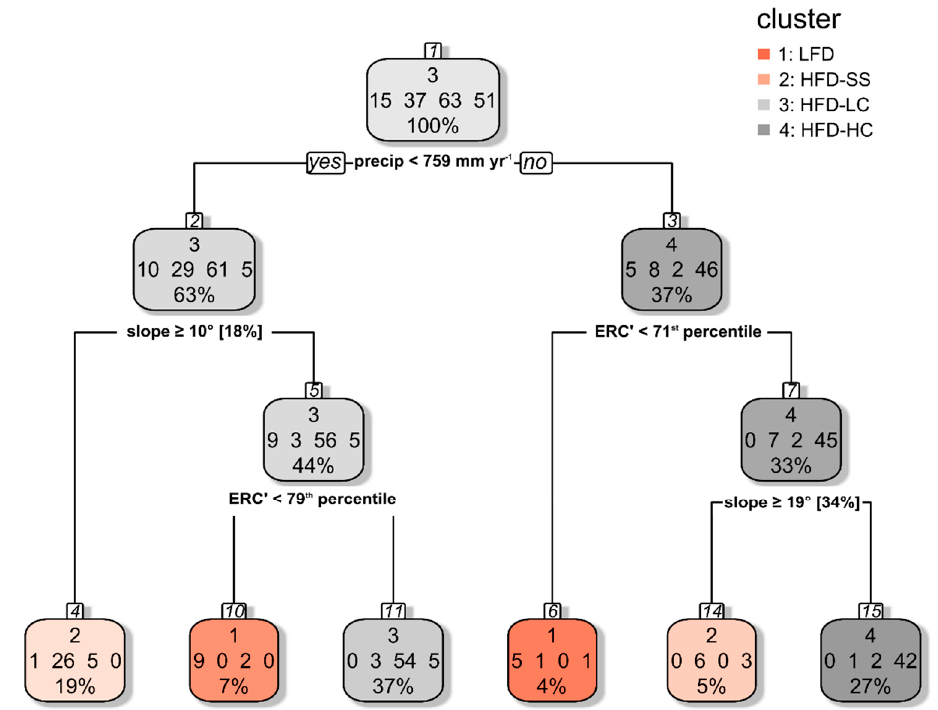
Figure 6. Decision tree used to classify US firefighter entrapments by cluster type. The values within each box, from top to bottom, include the cluster type with the most observations, the number of entrapments by cluster type (1 to 4 from left to right), and the percentage of observations that are defined by the particular set of conditions. See Table 2 for variable definitions.